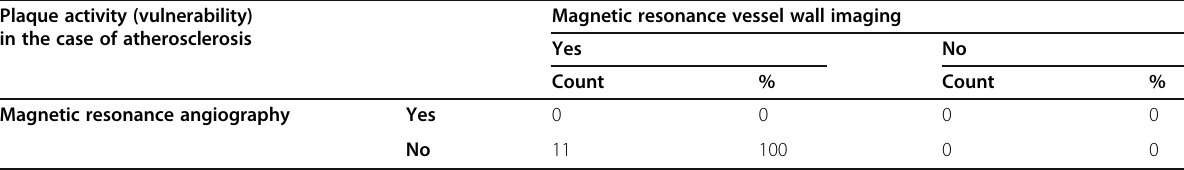
Table 5 Comparison between MRA and MR vessel wall imaging in the ability to detect vulnerability in cases of intracranial